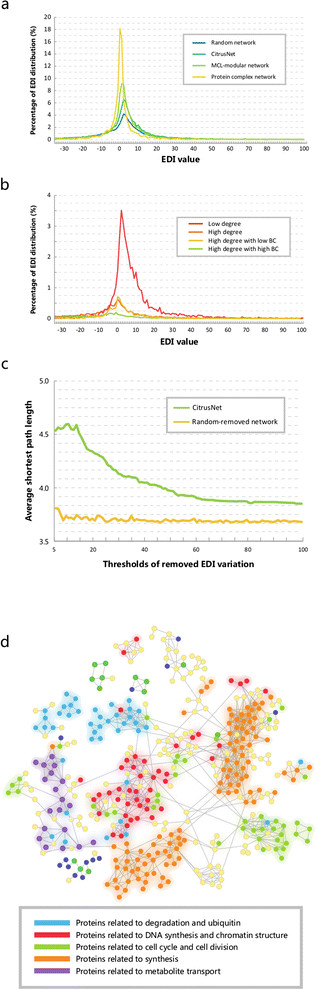
TheEDIdistribution and modular features of CitrusNet. (a)EDI distributions for CitrusNet, random network, MCL-modular network, and protein-complex network. (b)EDI distribution of CitrusNet based on topological properties. Red line represents low-degree nodes, orange line represents high-degree nodes, yellow line represents high-degree nodes with high BC, and grass green line represents high-degree nodes with low BC. Nodes with low-degree have the highest percentages of EDI values around zero. (c) Comparison of the average shortest path between CitrusNet and a random network, based on removed genes with different EDI variation values. (d) Modules in sub-networks of CitrusNet consisting of relatively highly expressed genes in four tissues. Node colors indicate different gene functions. Orange, synthesis; red, DNA synthesis and chromatin structure; blue, degradation and ubiquitination; purple, metabolite transport; grass green, cell cycle and cell division; yellow, other functions.